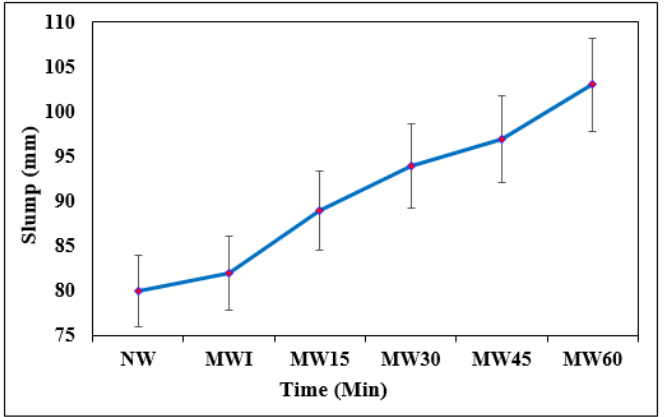
Figure 8. Slump value of concrete with NW and MW at different exposure times.